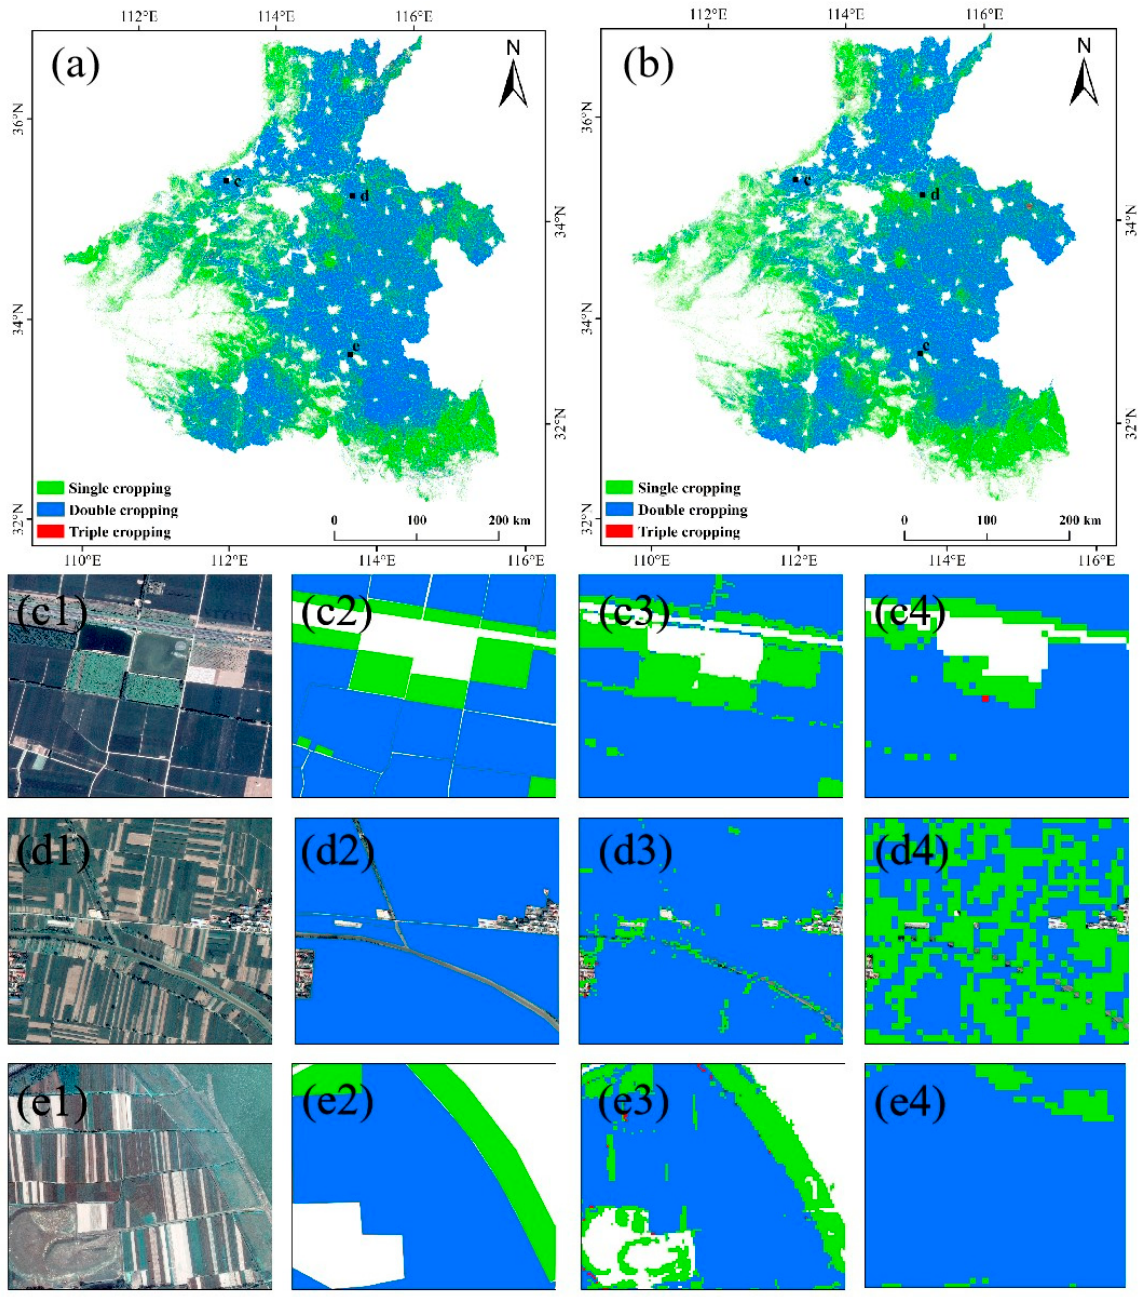
Figure 9. ( a ) Classification results of this paper. ( b ) Liu et al. (2020b) classification results. ( c1 – e1 ) Google Earth image. ( c2 – e2 ) Reference data by visual interpretation based on Google Earth image. ( c3 – e3 ) Classification results of this paper. ( c4 – e4 ) Liu et al. (2020b) classification results. Image source: Image 2021 CNES/Airbus. Color composite: RGB (red, green, blue).